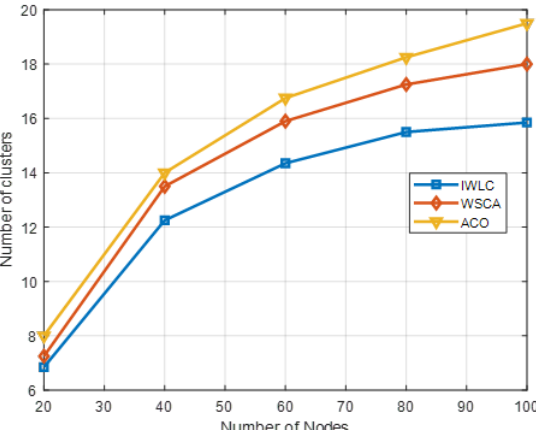
Figure 10. Number of clusters in different clustering schemes with varying numbers of UAV nodes.